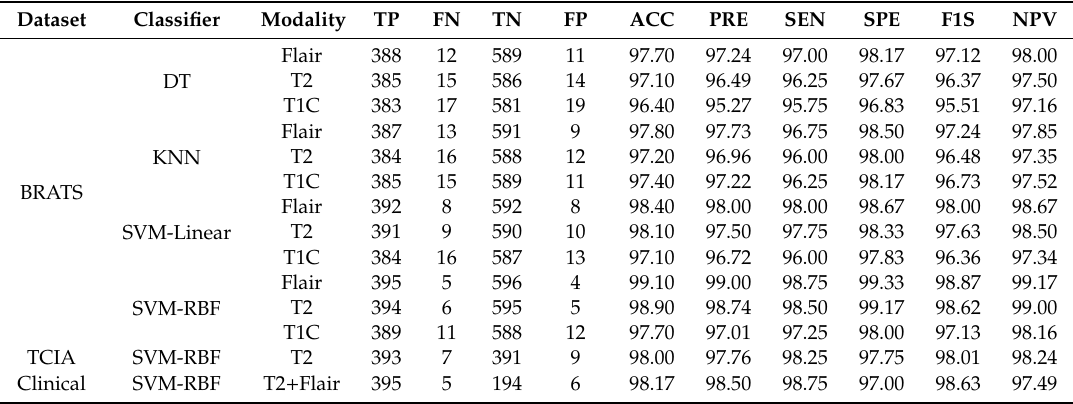
Table 4. Performance values obtained with the proposed VGG19 architecture.